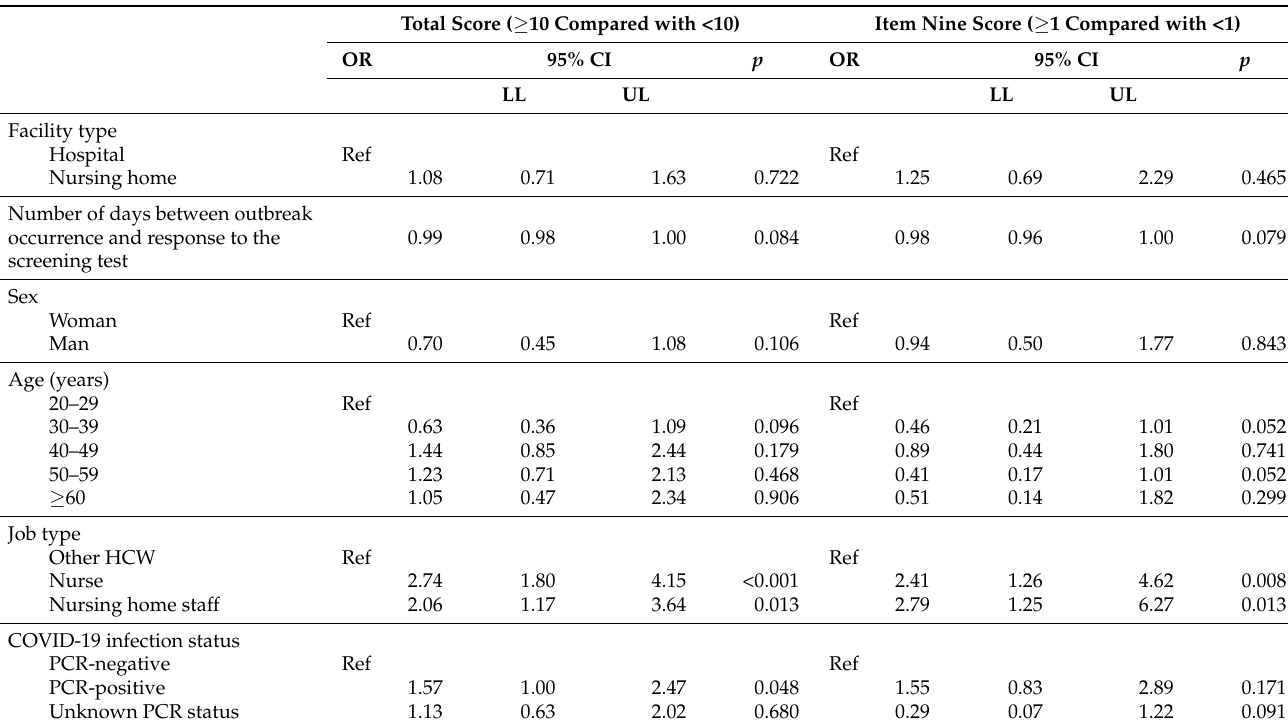
Table 2. Crude logistic regression analysis for PHQ-9.